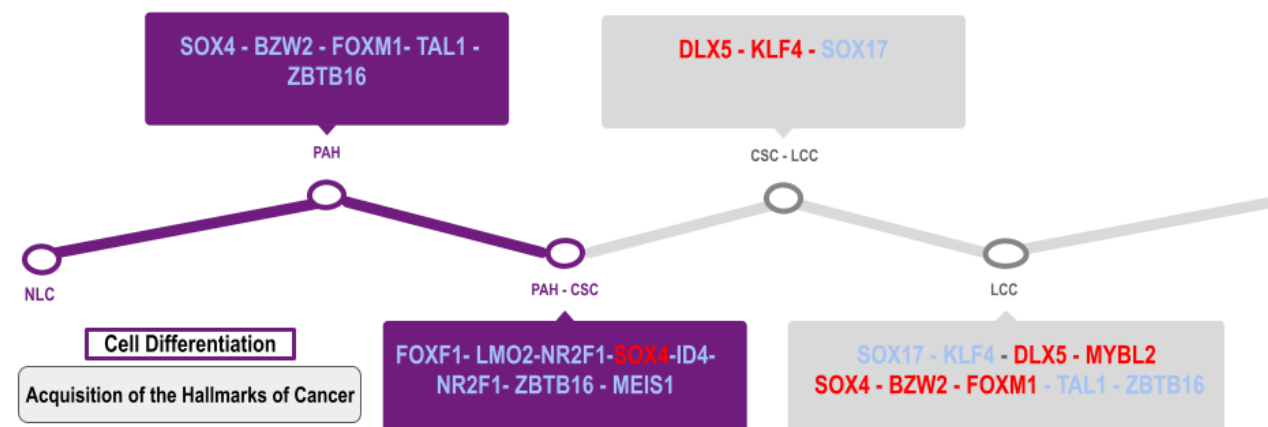
Figure 11. Model of the acquisition of cancer stem characteristics and lung cancer cell differentiation regulated by the most frequently dysregulated transcription factors, simultaneous to the acquisition of the hallmarks of cancer. First are normal lung cells (NLC), then pulmonary arterial hypertension cells (PAH), cancer stem cells (CSC), and differentiated lung cancer cells (LCC). FOXF1 (forkhead box F1) is a stemness reprogramming mediator (when mesenchymal stem cells fuse with lung cancer cells) which is also related to the inhibition of cell growth, proliferation, and migration [52]; therefore, it must be downregulated in lung cancer cells (Table 1). FOXF1 downregulation in lung-resident mesenchymal stromal cells is associated with upregulation of genes important for the regulation of high cell proliferation, migration, and inflammatory responses [53]. FOXF1 is co-expressed in the CCP of LC RNA-Seq and PAH, suggesting that it is an important regulator for the tumoral process (Table S5). FOXF1 is related to the positive regulation of cell migration, transcription, and the negative regulation of inflammatory response (Table S1), suggesting its importance as a tumor suppressor gene regulating the inflammation, invasion, and metastasis of cancer stem cells (CSC) (Figure 11). In vitro hypomethylation of FOXF1 is able to increase its